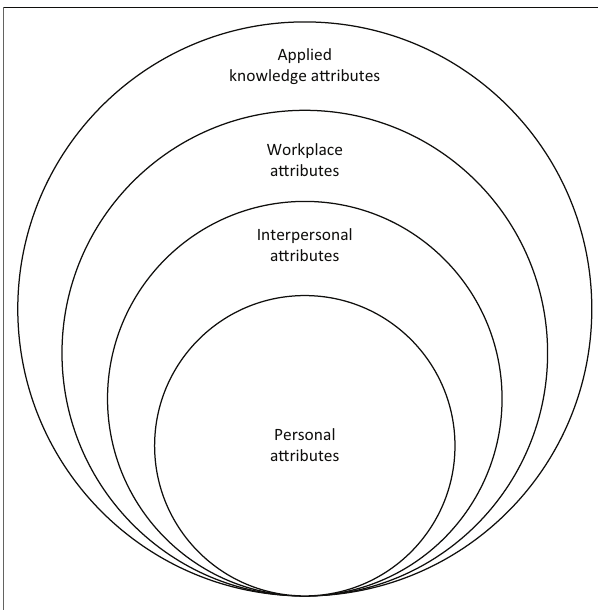
FIGURE 2: The interrelations between the four categories of employability attributes.